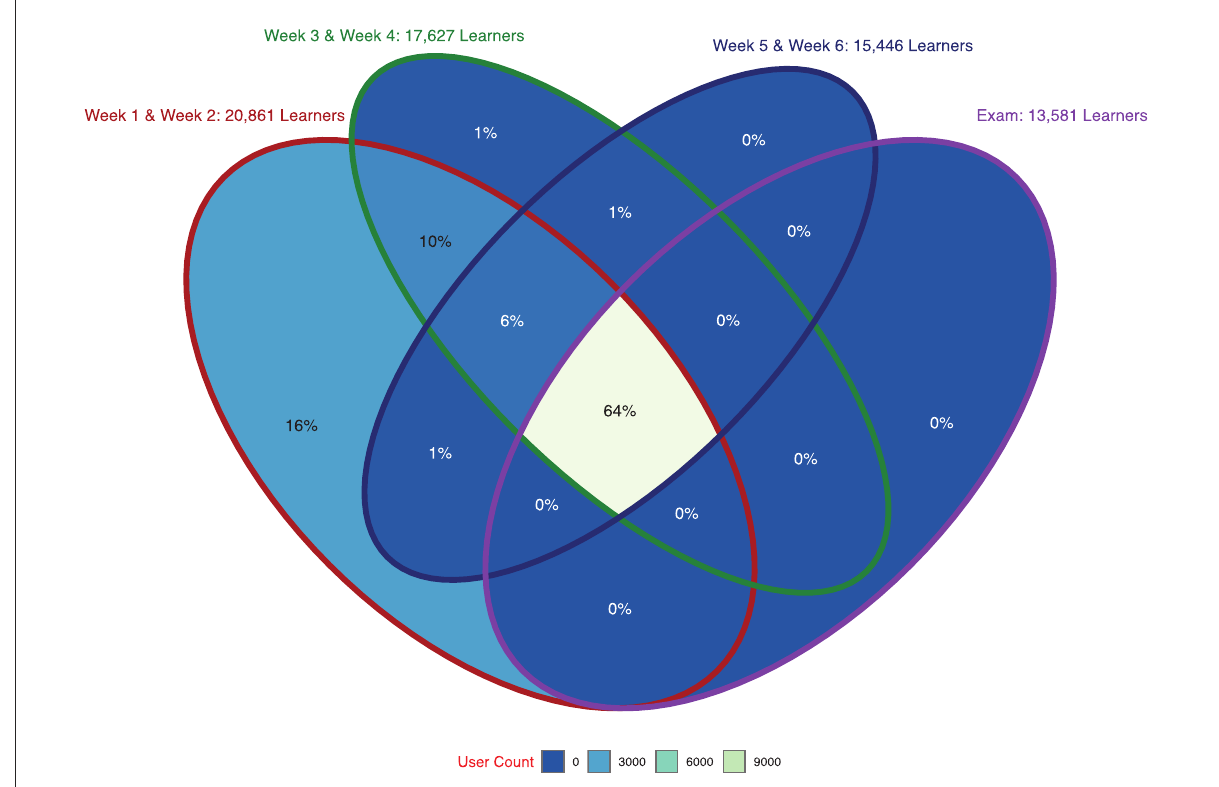
FIGURE2 Active participation in the monoliths (i.e., ISec 2014 , ISec 2016 , ISec 2018 , ISec 2020 , WWW 2015 , and WWW 2017 ). The Venn diagram visualizes how many users participated in any given combination of course weeks or the final exam,